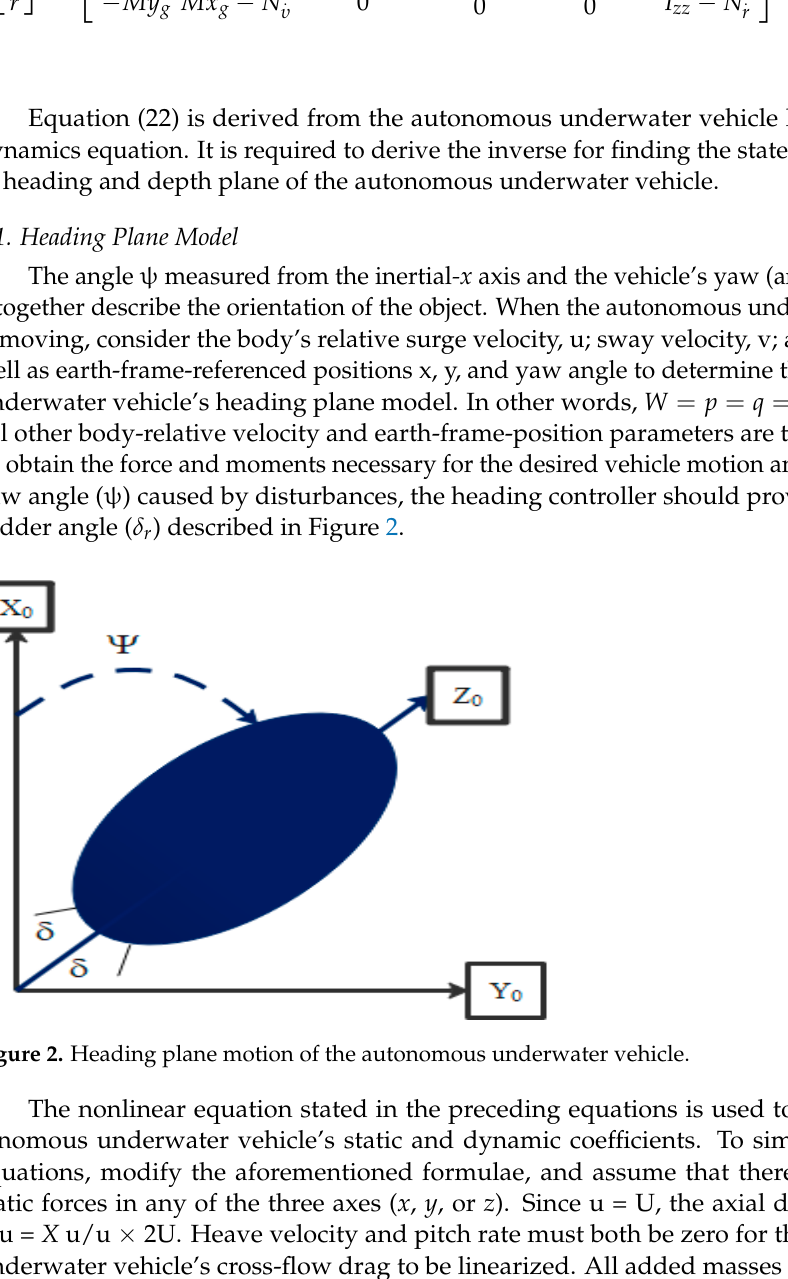
Table 2. Value of linearized coe ffi cient.